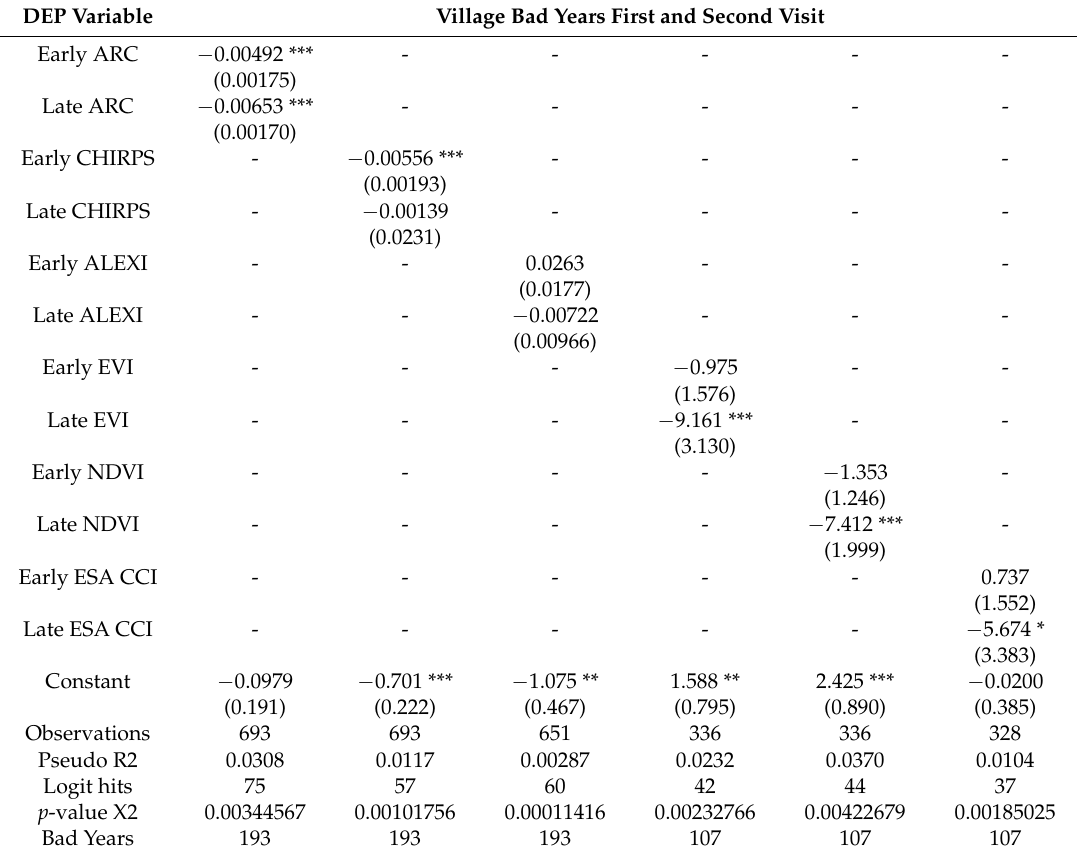
Table 6. All datasets, village bad